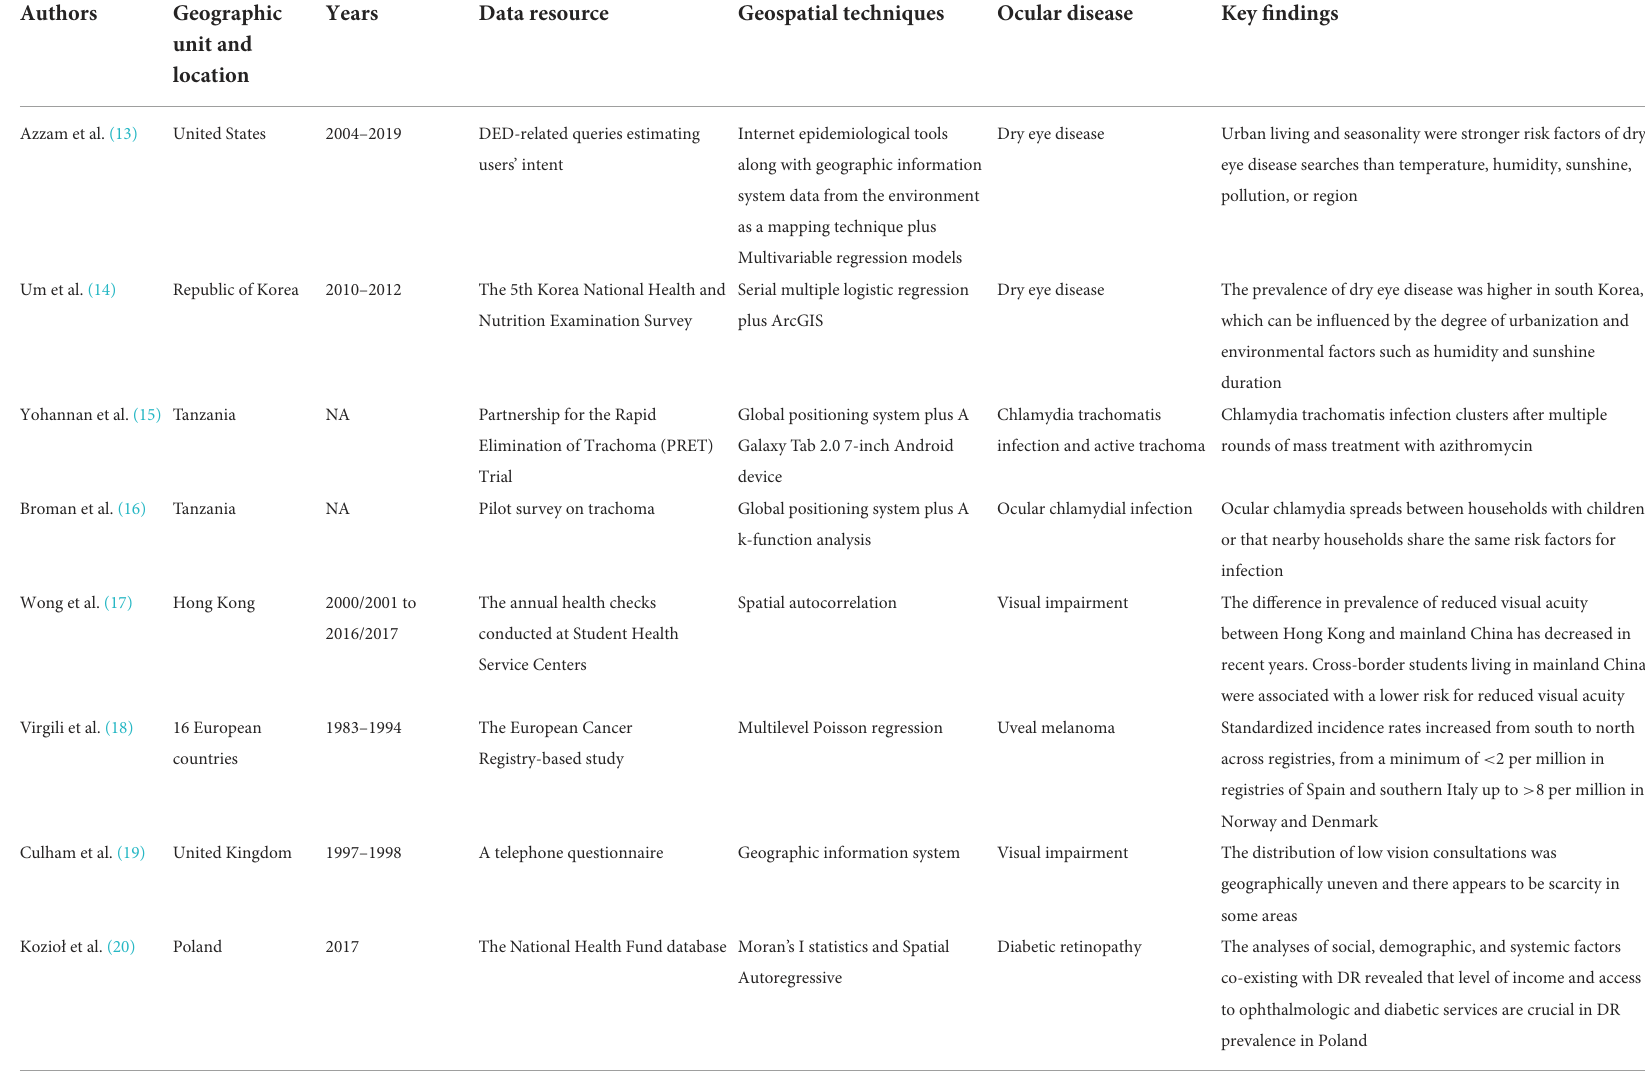
TABLE 1 Methods for spatial analysis with examples of applications and findings in